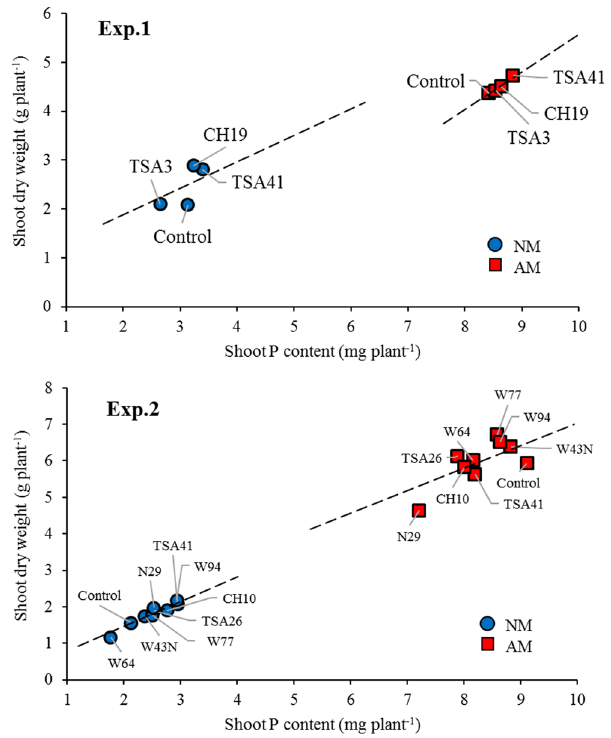
Figure 2. Linear relationship between shoot dry weight and shoot P content of mycorrhizal (AM) and non mycorrhizal (NM) Z. mays L. genotype Oh43 inoculated with different bacterial strains. Results of the regression analysis are as follows: Exp. 1, NM y = 0.542x + 0.796, R 2 = 0.631; AMF y = 0.768x − 2.106, R² = 0.609; Exp. 2, NM, y = 0.678x + 0.111, R² = 0.835; AMF y = 0.619x + 0.851, R² = 0.483. For abbreviations see Table